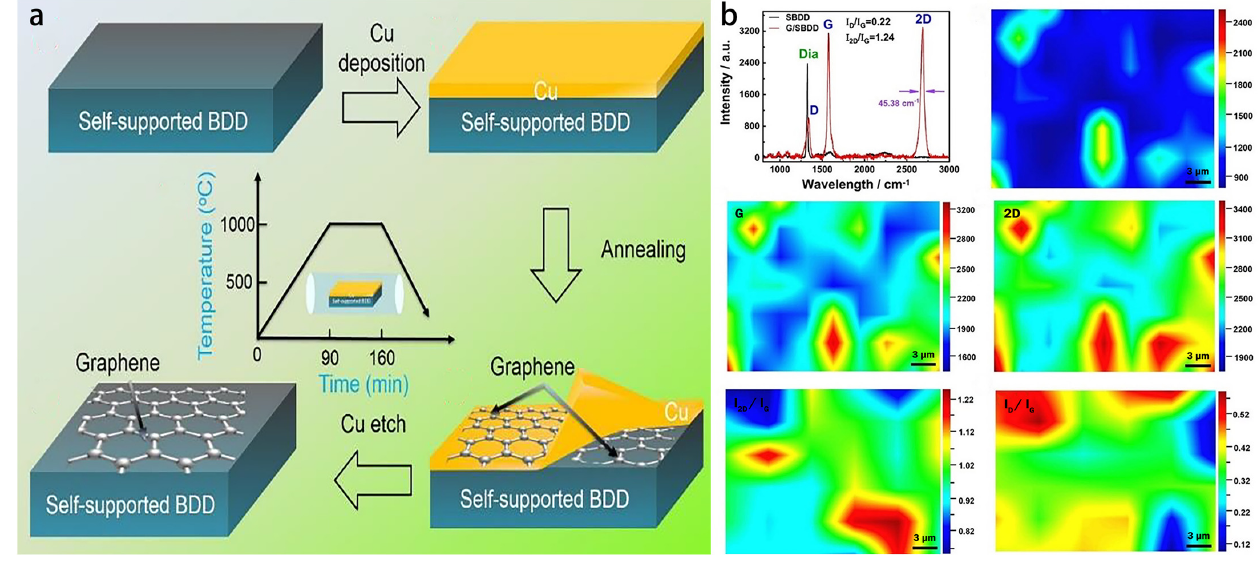
Figure 8. ( a ) Schematic diagram of G/SBDD preparation process; ( b ) Raman spectra of SBDD and G/SBDD. and